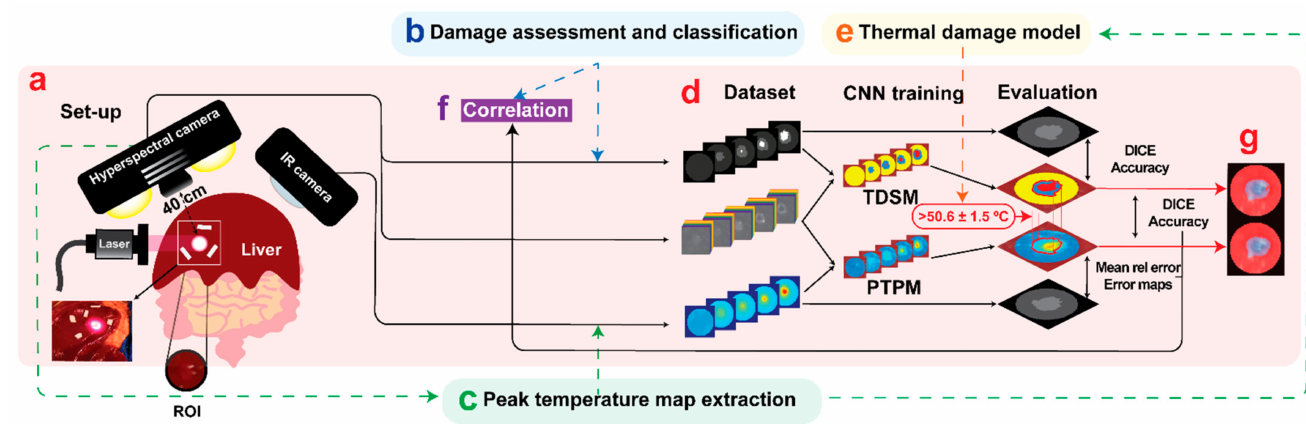
Figure 1. ( a ) The experimental setup. The laser ablation procedure was performed on the in vivo pig liver surface. The ablation progress was recorded by HS and IR cameras. A circular ROI centered on the ablation spot was defined in the images and used in the CNN implementation. The data collected during the experiment were used to obtain the final dataset for training the TDSM and PTPM. ( b ) TDSM dataset creation. Starting from the damage assessment of the histology, RGB images collected from the HS camera were manually annotated. ( c ) PTPM dataset creation. Extraction of peak temperature maps from the IR camera video. ( d ) The TDSM was trained with supervised learning using hypercubes and damage zone annotations obtained from the RGB images. The PTPM was trained with supervised learning using the hypercubes and peak temperature maps extracted from IR video. The two models were trained and tested using pixels in the ROIs. ( e ) Peak temperature maps were used as a model for thermal damage outcome. ( f ) The PTPM was validated by applying a linear correlation with histology. ( g ) As a final step, damage predictions of the two models were compared and the PTPM was validated also using TDSM results. The area of damage in the predicted peak temperature maps was obtained using the threshold of 50.6 ± 1.5 ◦